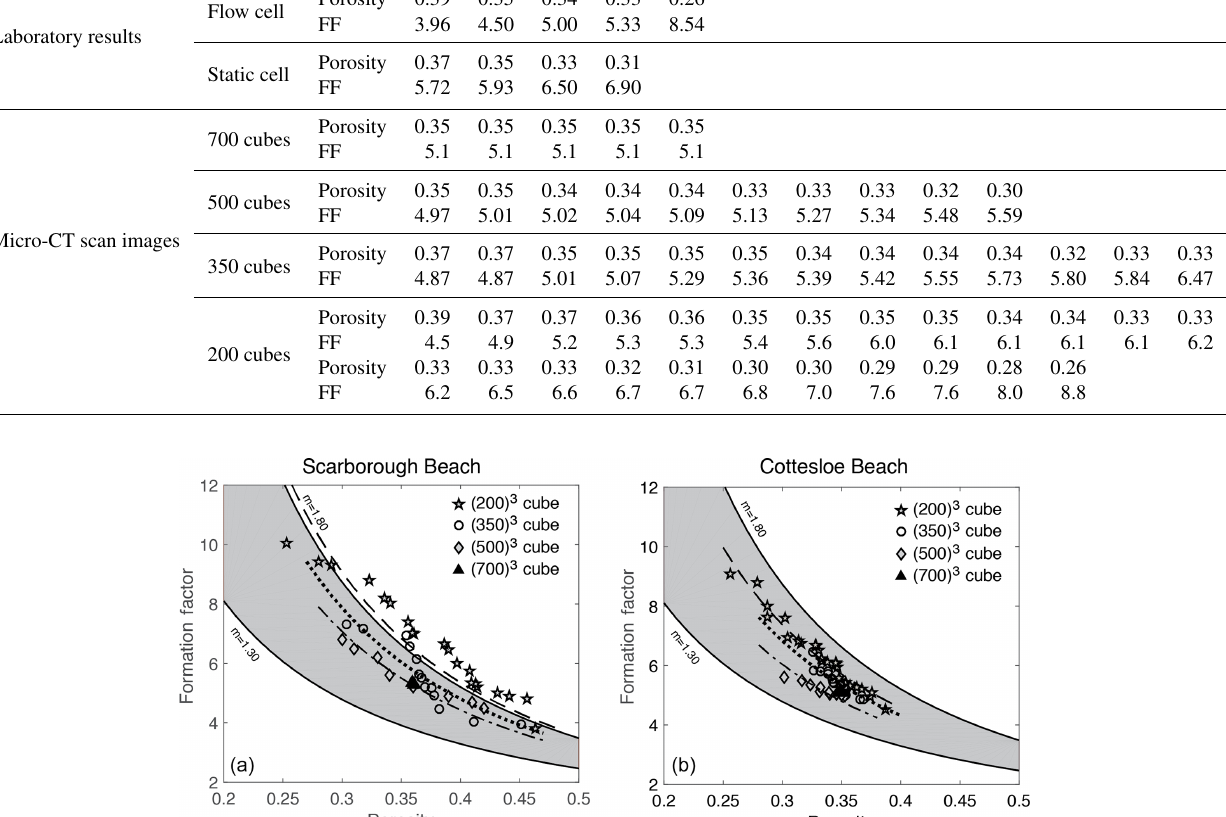
Laboratory results